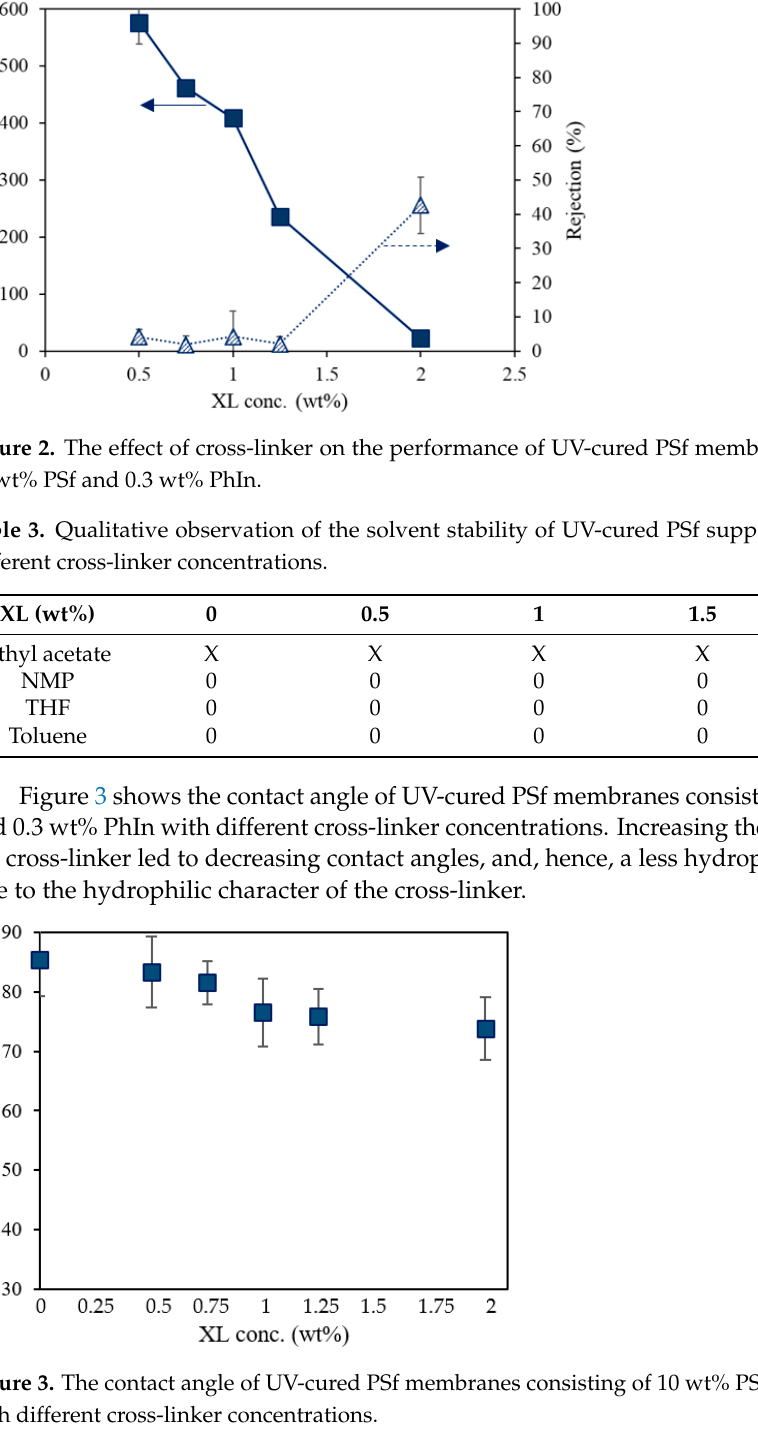
Figure 4. Cross-linker conversion of UV-cured PSf membranes consisting of 10 wt% PSf, different cross-linker concentrations, and 0.3 wt% PhIn. 3.3. Influence of Energy Density In the abovementioned experiments, the energy dose to cure the membranes was 28 J cm − 2 with an irradiation time of 10 s. In Figure 5, the effect of 50% reduction in energy dose is shown. When the energy density was halved, the permeance of the UV-cured PSf membranes increased drastically from 22.5 to 406.3 L m − 2 h − 1 bar − 1 while the RB rejection decreased from 42.7 to 7.7%. A higher energy dose can result in a higher cross-linking degree, which can explain the higher rejection for the membrane cured with the highest energy density [23]. On the other hand, as could be clearly observed experimentally, a high-energy dose generated more heat at the membrane surface. This can cause drying of the pores on the membrane surface and, therefore, some pore collapse with significant loss of surface porosity [28]. The decreased porosity and pore sizes led to an increased